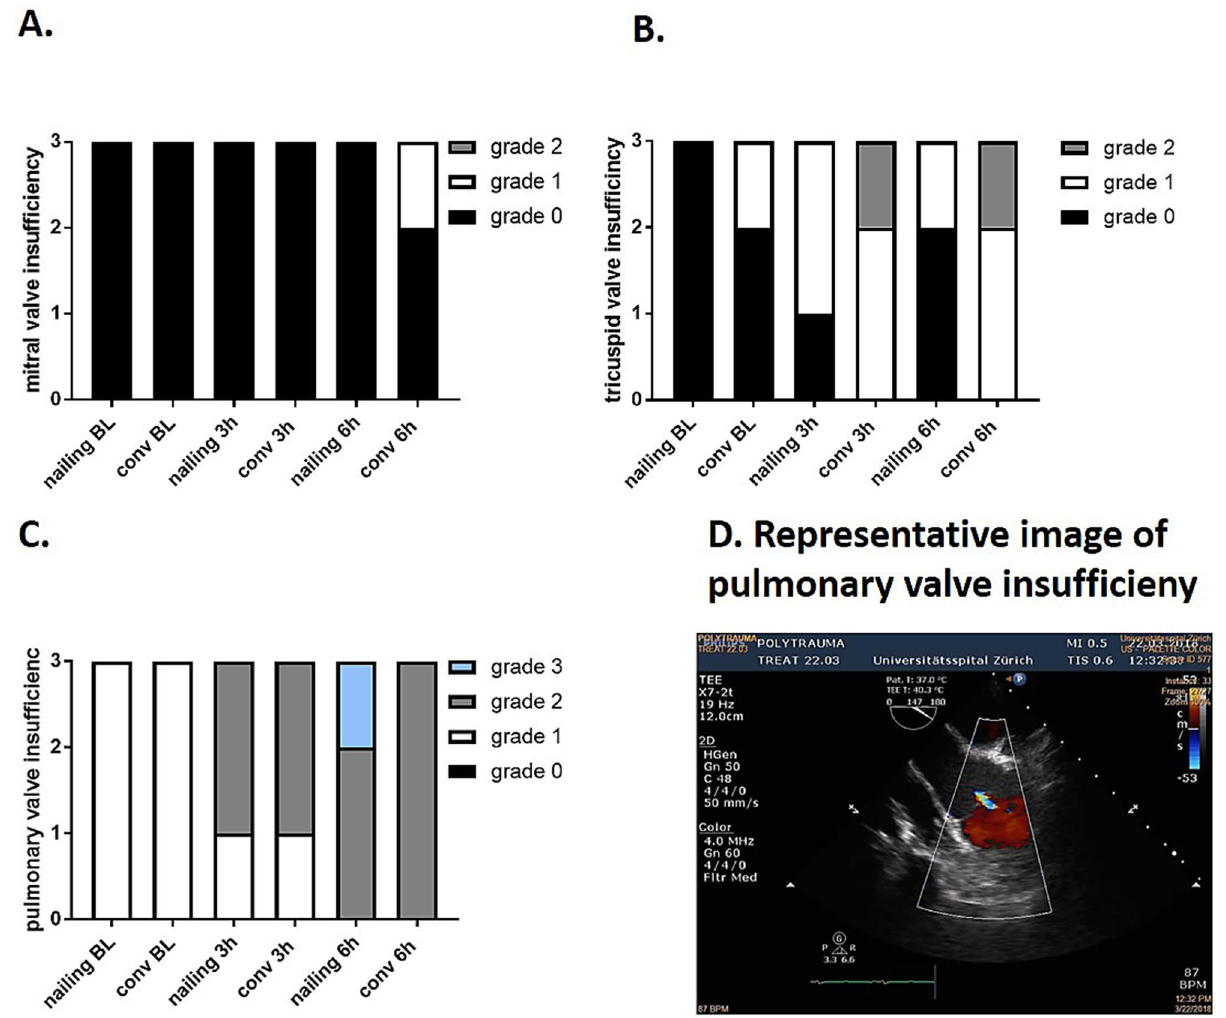
either femoral nailing or conventional reaming as therapeutic treatment. ( B ) Subgroup analysis of tricuspid valve insufficiency in at BL, 3 and 6 h after trauma. ( C ) Subgroup analysis of pulmonary valve insufficiency determined at BL, 3 h and 6 h after trauma after femoral nailing and conventional reaming detected by transesophageal echocardiography. ( D ) Representative image of pulmonary valve insufficiency. Femoral nailing group n = 3, conventional reaming n =